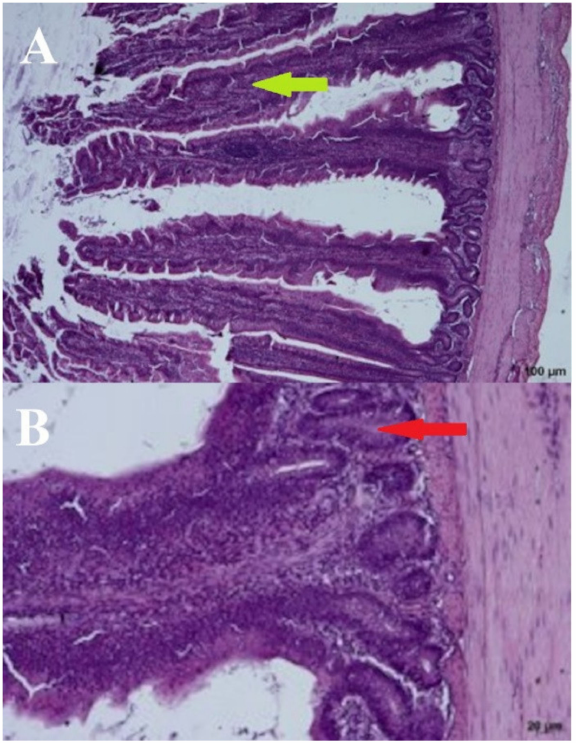
Figure 5. Positive control—( A ) Cross section through the intestine—100 µ m and ( B ) crypts–20 µ m. Arrows: bold green—villi, red—crypts.